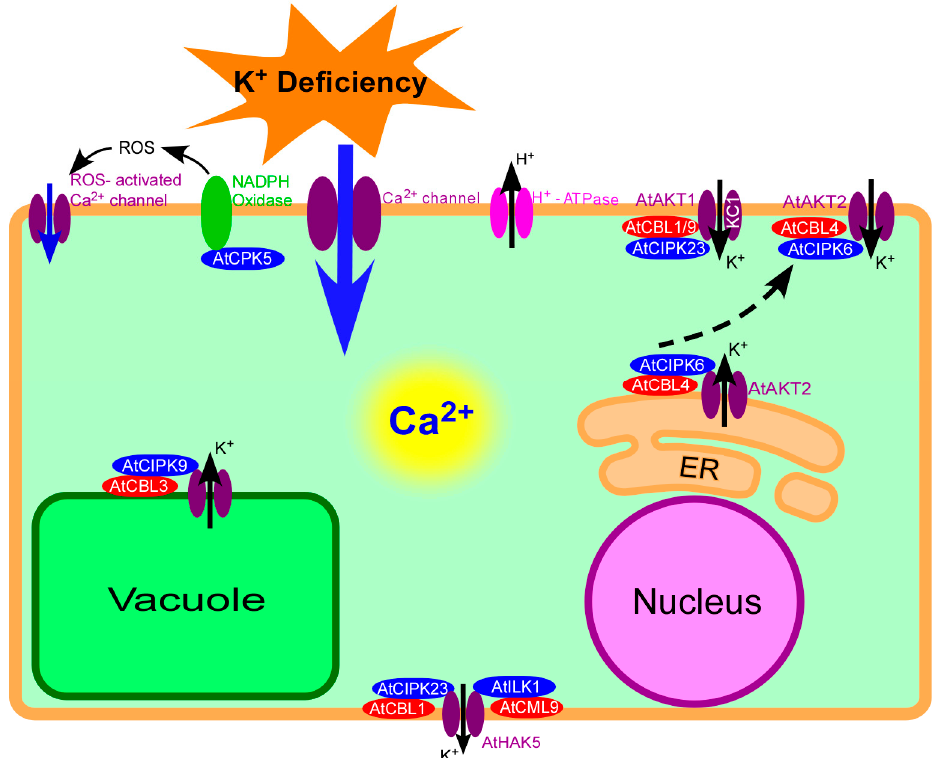
Figure 1. Calcium signaling in Arabidopsis response to K + deficiency. Plants can perceive external K + deficiency and generate K + deficiency signals in plant cells. The signal Ca 2+ can be transduced in cytosol, and eventually regulate the downstream targets at the transcriptional and posttranslational levels. ER: Endoplasmic